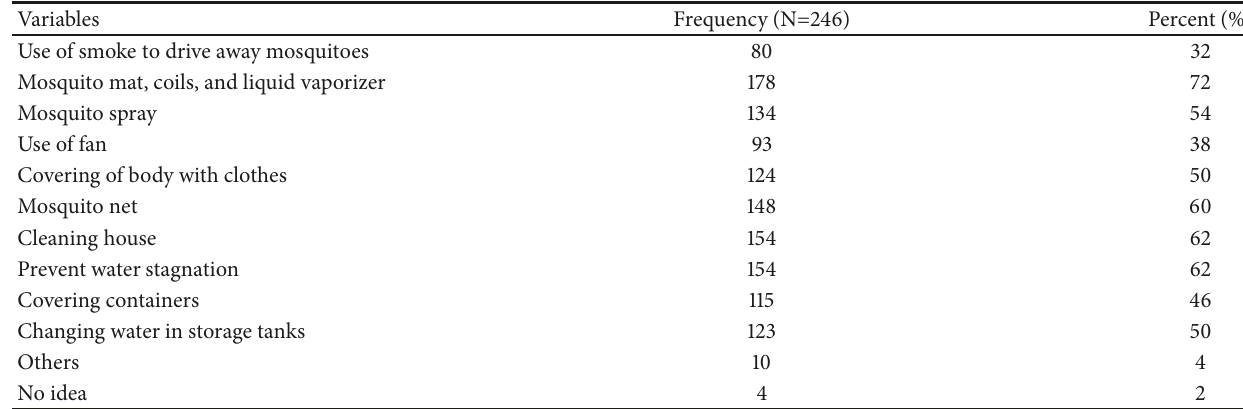
Table 4: Strategies/materials used in malaria